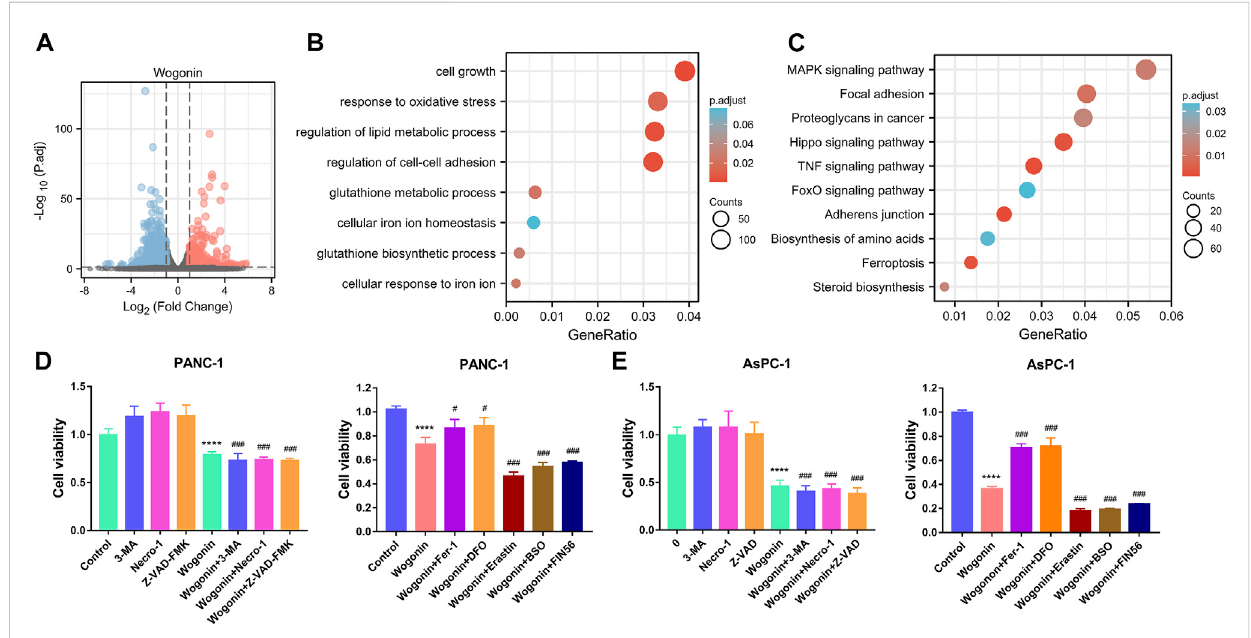
FIGURE 2 Screening of the death mode of pancreatic cancer cells induced by wogonin. (A) The genes regulated by wogonin in PANC-1 cells. (B) Enrichment analysis of GO in wogonin group compared with control group assayed by RNA-sequence in PANC-1 cells. (C) Enrichment analysis of KEGG signaling pathway in wogonin group compared with control group assayed by RNA-sequence in PANC-1 cells. (D) Effects of three inhibitors on the death of pancreaticcancercellsinducedbywogonin. (E) Effectsofferroptosisinhibitorsonthedeathofpancreaticcancercellsinducedbywogonin.**** p